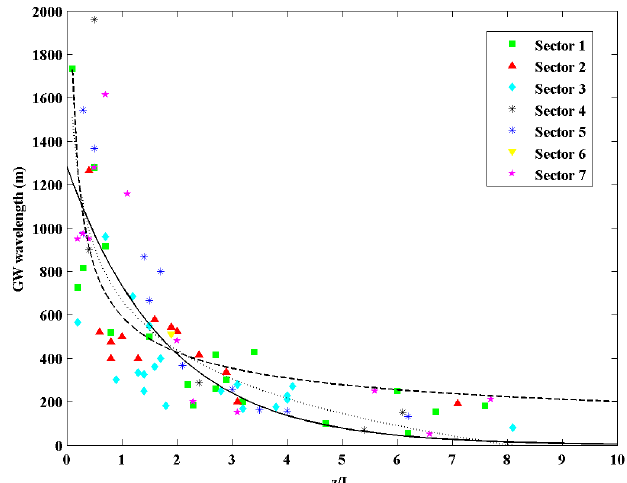
Figure 12. Wavelength of detected waves (GW) versus the atmospheric stability parameter ( z/L , where z is the measurement height and L is the Obukhov length), measured at the highest level (=10 m) and computed after the wave-filtering process. Different colours and symbols refer to data belonging to different wind direction sectors. The continuous black line refers to the exponential regression: y = 1287 e ( − 0.56x) (R 2 = 0.64); the dashed and dotted black lines refer to the power-law regressions: y = 592 x − 0.47 (R 2 = 0.47) and y = 5687 x − 0.06 − 5018 (R 2 = 0.62),